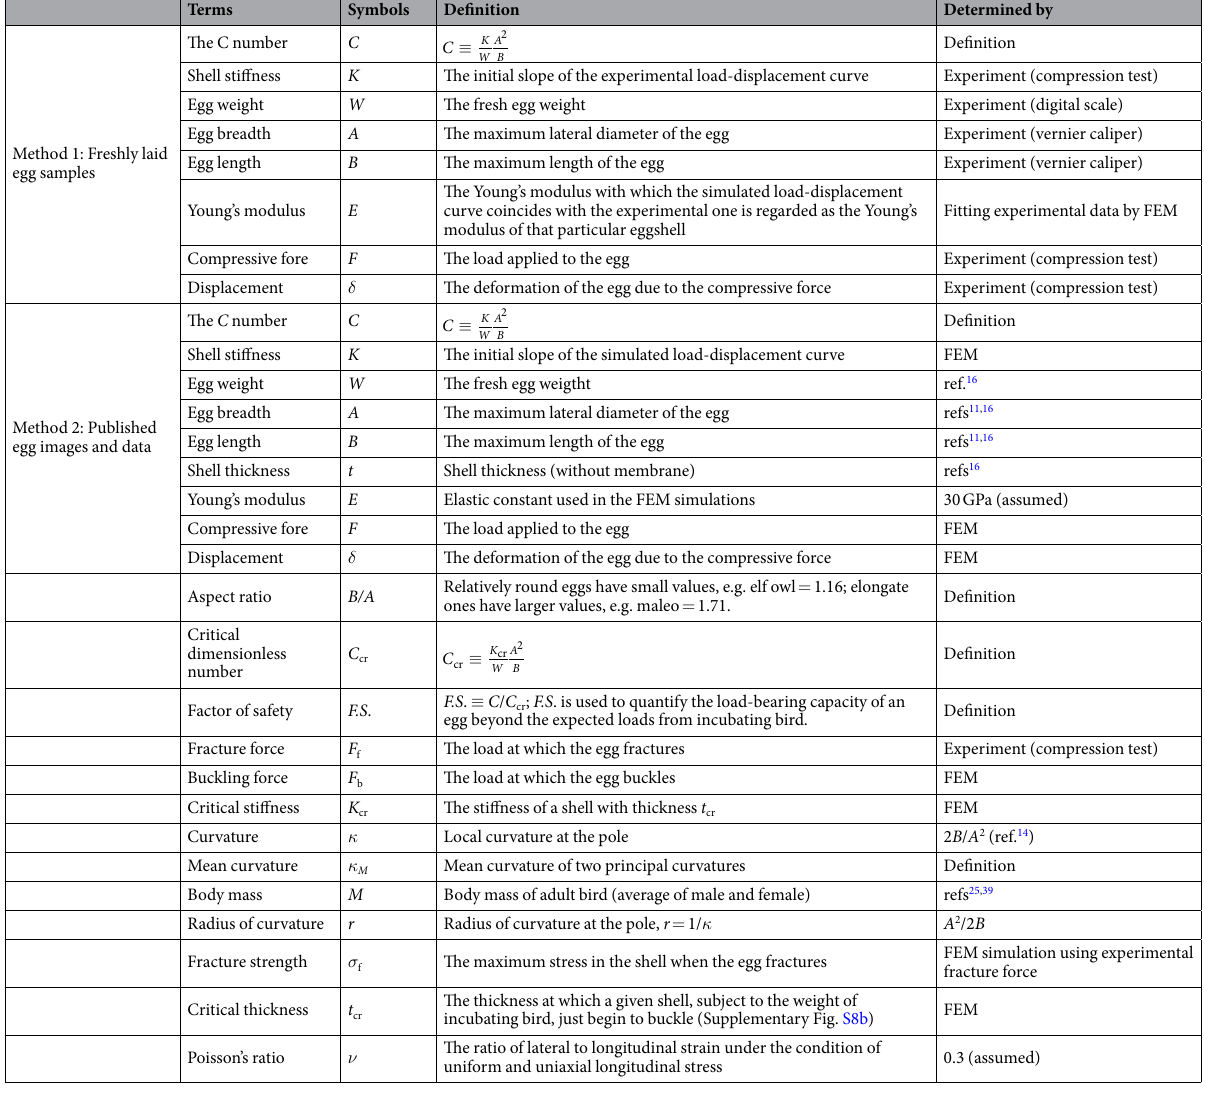
Table 1. Terminology and